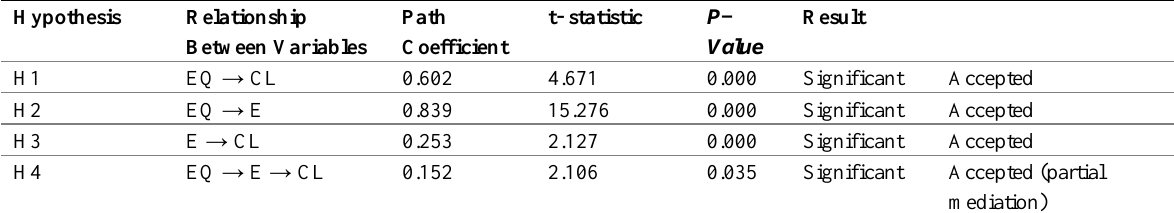
Table 2 : Hypothesis Testing